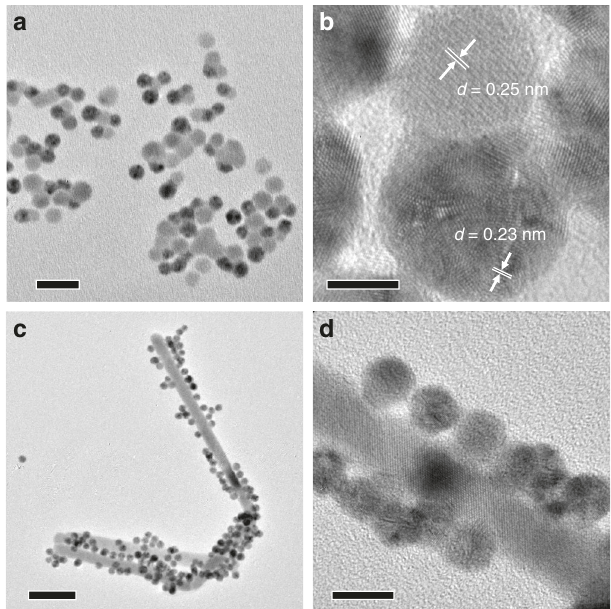
Fig. 6 TEM images showing the welding between Au NPs and different chalcogenide NPs. a , c Low and b , d high magni fi cation TEM images of a , b Au – Ag 2 Se HNPs welded from spherical Au and Ag 2 Se NPs and c , d Au – Ag 2 S HNPs welded from spherical Au and rod-like Ag 2 S NPs. Scale bars are 20 nm in a , 5 nm in b , 50 nm in c , and 10 nm in